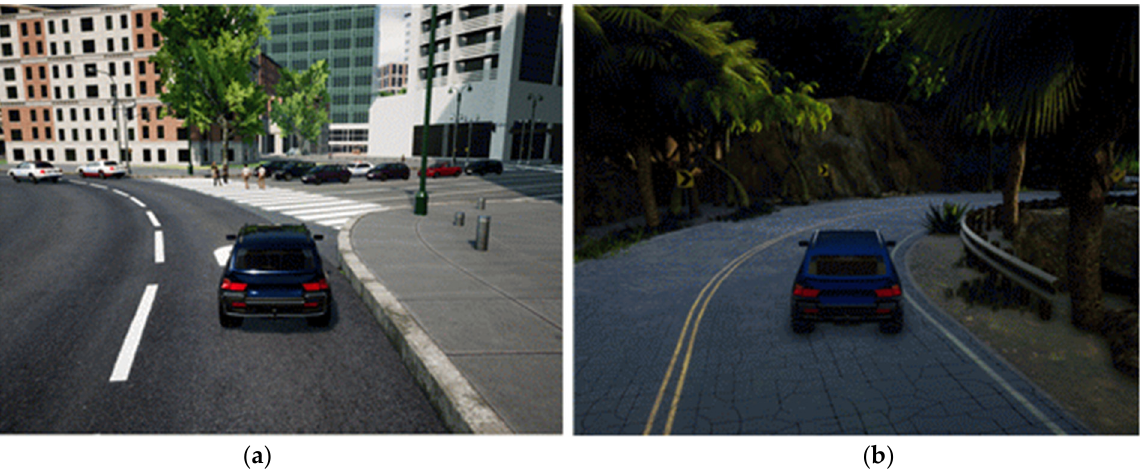
Figure 3. The training environment using AirSim (city road and mountain road). ( a ) city road; ( b ) mountain road.